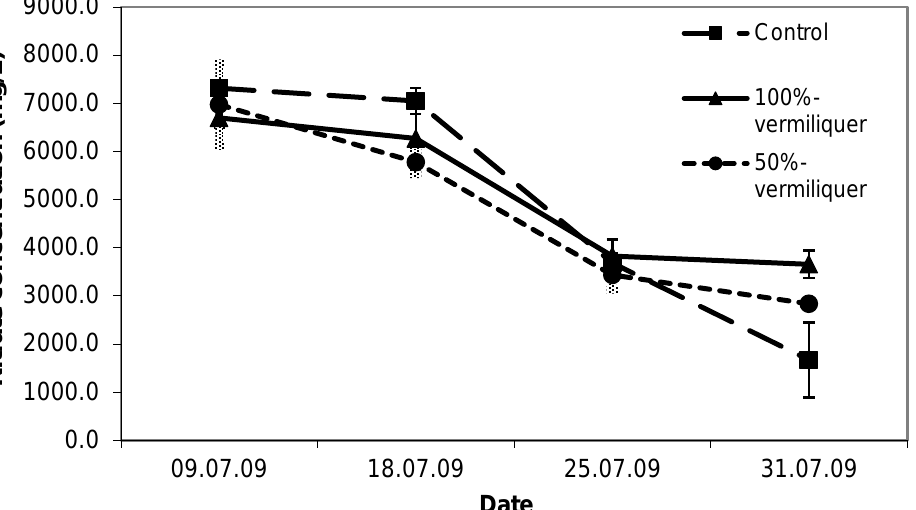
Figure 8. Trend in nitrate concentration (mg/L) in sap in the control, 100% and 50% vermiliquer treatments over time in Study VIII, transplanted 29 June 2009. Vertical bars represent SD of the mean.